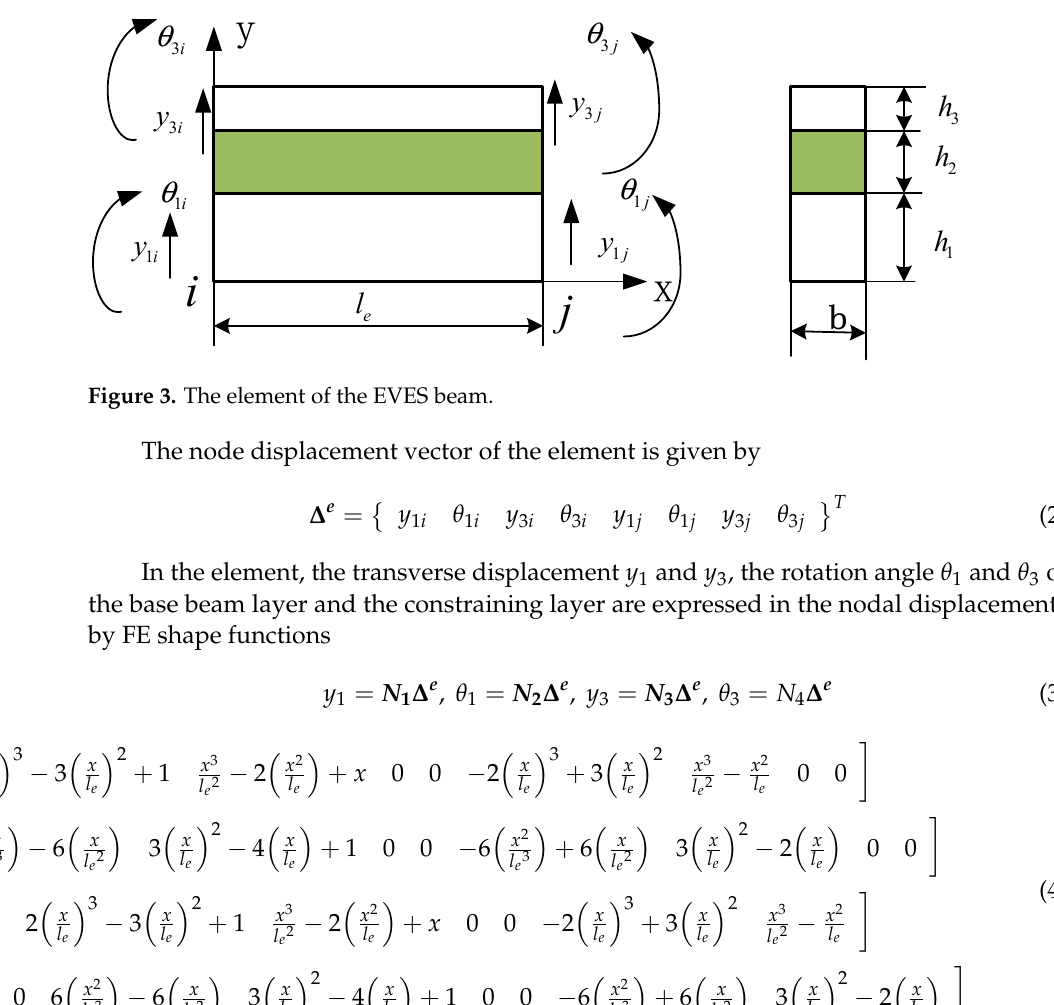
Figure 2. The geometric and deformation relationship of the EVES beam.